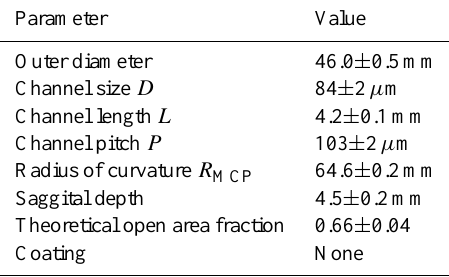
Table 5. Prototype MCP